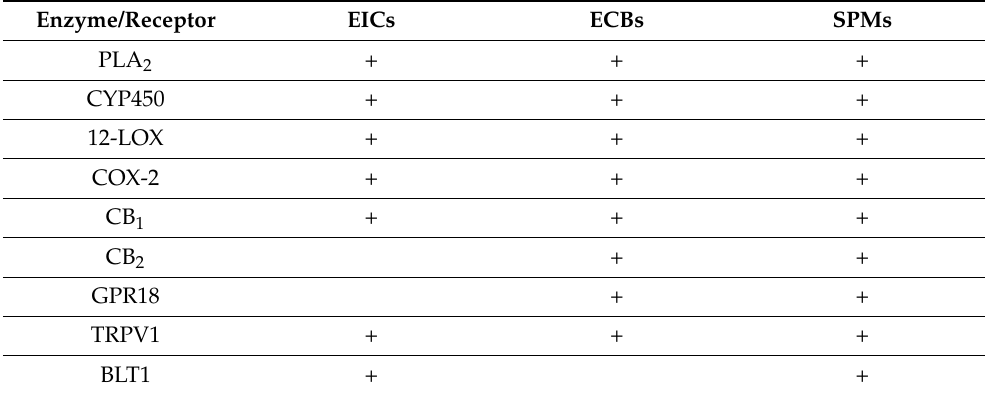
Table 2. Common metabolic enzymes and receptors of different classes of bioactive lipids. Enzyme/Receptor EICs ECBs SPMs PLA